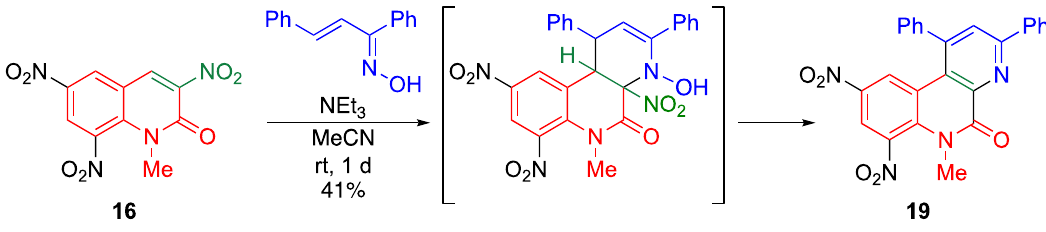
Scheme 3. Diels-Alder cycloaddition of trinitroquinolone 16 with cyclopentadiene.